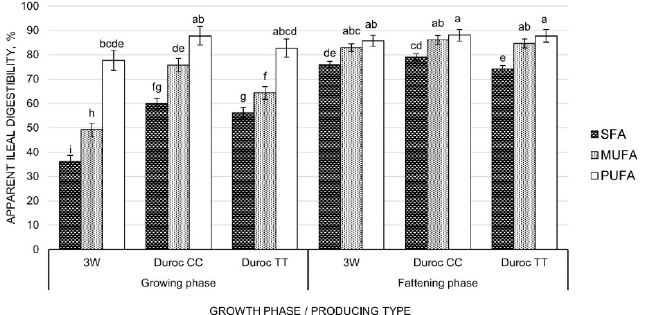
Figure 1. Apparent ileal digestibility of fatty acids, by three-way (3W) crossbred pigs and Duroc purebred pigs of TT/CC SCD genotype, at two growth phases (growing vs. fattening). a, b, c, d, e, f, g means with different superscripts differ significantly ( p ≤ 0.05). Saturated fatty acids (SFA): C14:0, C16:0, C17:0, C18:0, C20:0, and C22:0; Monounsaturated fatty acids (MUFA): C16:1, C18:1 c 9, C18:1 c 11, and C20:1 c 11; Polyunsaturated fatty acids (PUFA): C18:2 c 9, c 12 and C18:3 c 9, c 12, and c 15.